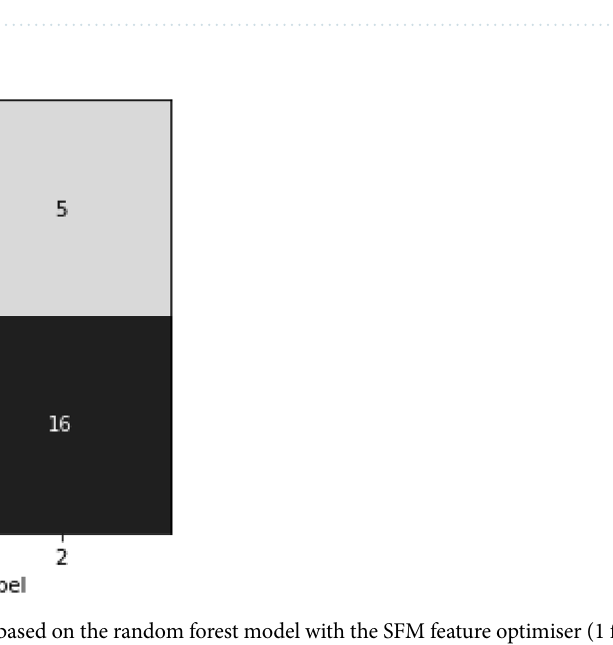
Table 3. Feature importance from SelectFromModel based on random forest model. Features are ordered according to their importance score.